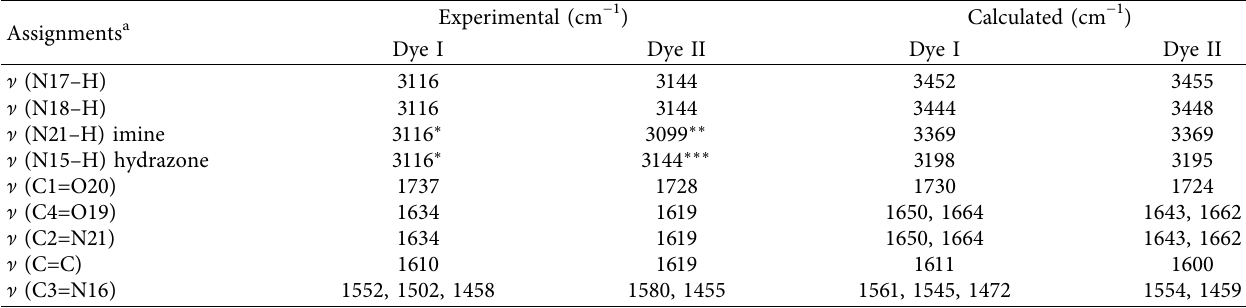
Table 2: Some vibration frequencies (cm − 1 ): experimental and calculated by DFT/B3LYP/6-311G++(d, p) for imine-diketo-hydrazone forms of dyes I and II.